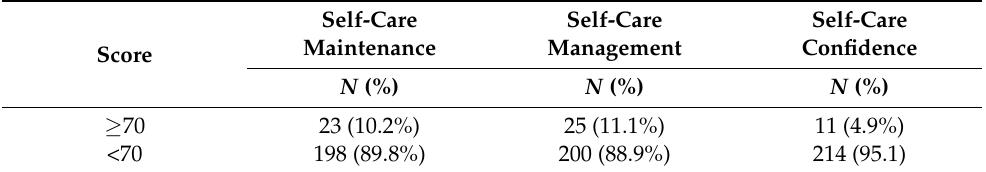
Table 3. Frequencies of appropriate self-care behaviour.